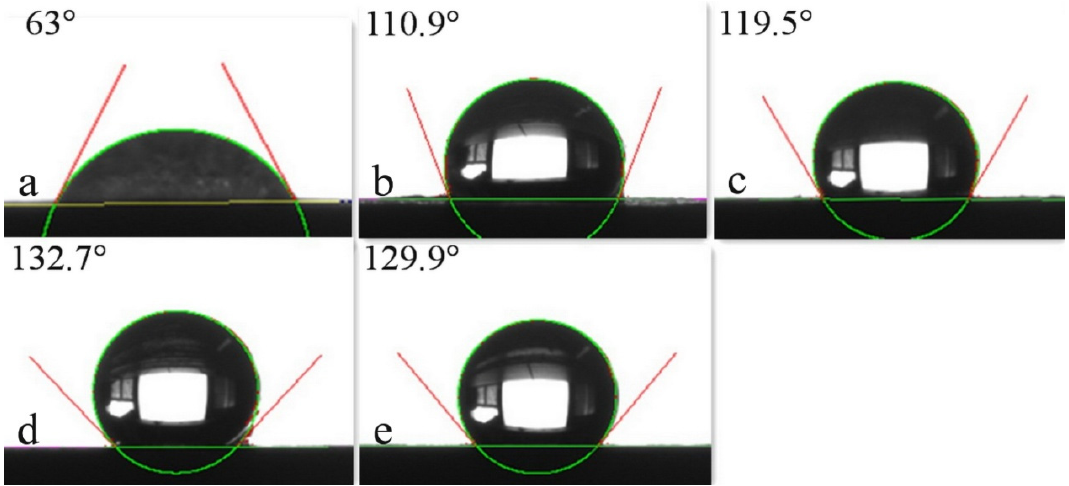
Figure 6. Hydrophobic diagram of metallized Pinus sylvestris wood veneer(( a ) the original wood,( b ) sputtering Al 20 s,( c ) sputtering Al 50 s,( d ) sputtering Al 15 min,( e ) sputtering Al 60min).